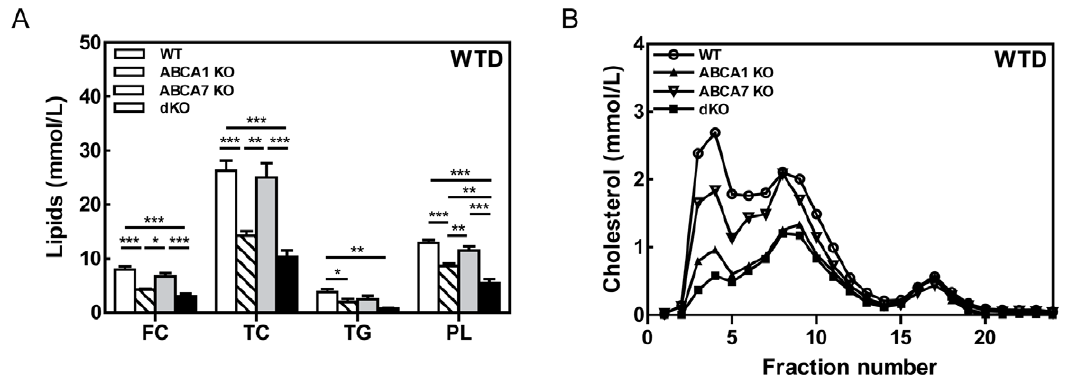
Figure 2. Plasma lipid levels and cholesterol lipoprotein distribution profile after 10 weeks WTD feeding of LDLr KO mice reconstituted with WT, ABCA1 KO, ABCA7 KO and dKO bone marrow. Blood samples were drawn after an overnight fast. ( A ) The concentrations of cholesterol, phospholipids and triglycerides in serum were determined using enzymatic colorimetric assays. ( B ) The distribution of cholesterol over the different lipoproteins was determined by fractionation of serum from individual mice using a Superose 6 column. Fractions 2 to 5 represent VLDL; fraction 6 to 14, LDL; and fractions 15 to 20, HDL, respectively. Values represent the mean 6 SEM of $ 6 mice per group. Statistically significant difference *p , 0.05, **p , 0.01, and *** p , 0.001.